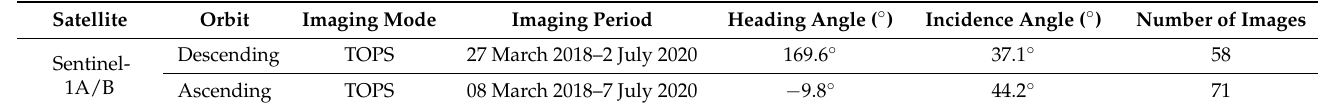
Table 2. Basic parameters of SAR